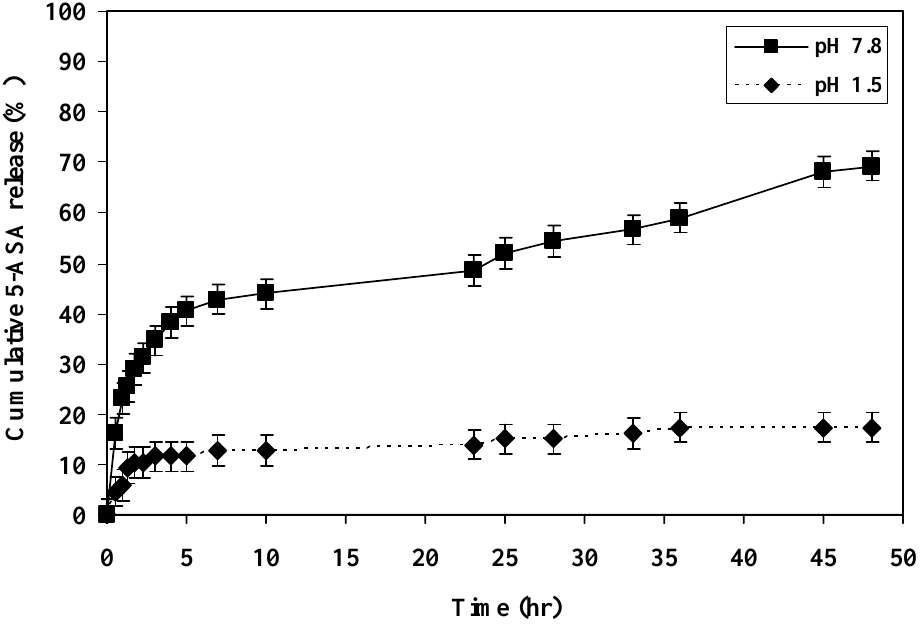
Figure 1. In vitro 5-ASA release from polymer IV in phosphate buffer solutions (pH 7.8 and 1.5) at 37 ºC.